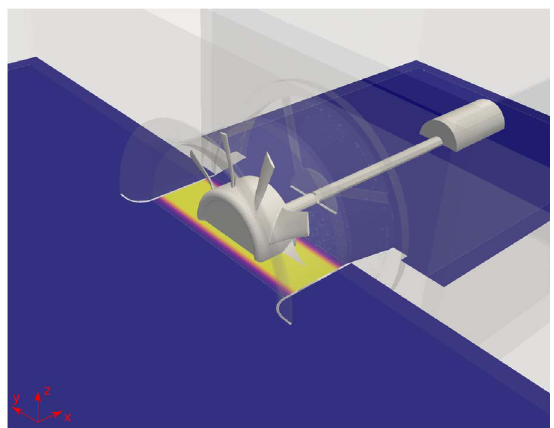
Figure 20. Spatial blending function reducing the sources smoothly before the non-conforming interface. In regions depicted in yellow the full sources are applied, and in regions depicted in blue no sources are used.